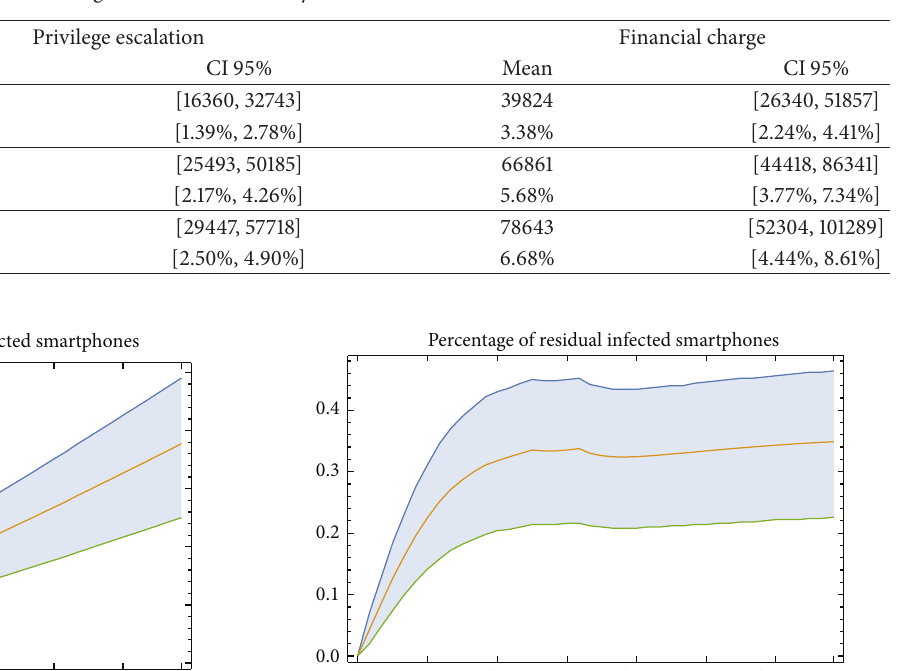
Table 12: Mean and CI 95% of the accumulated infected smartphones by privilege escalation and financial charge in July 2013, July 2014, and December 2014 in the community of Valencia and the corresponding percentages predicted by the model. These figures can give us an idea about the amount of money that the financial charge malware moves every month.